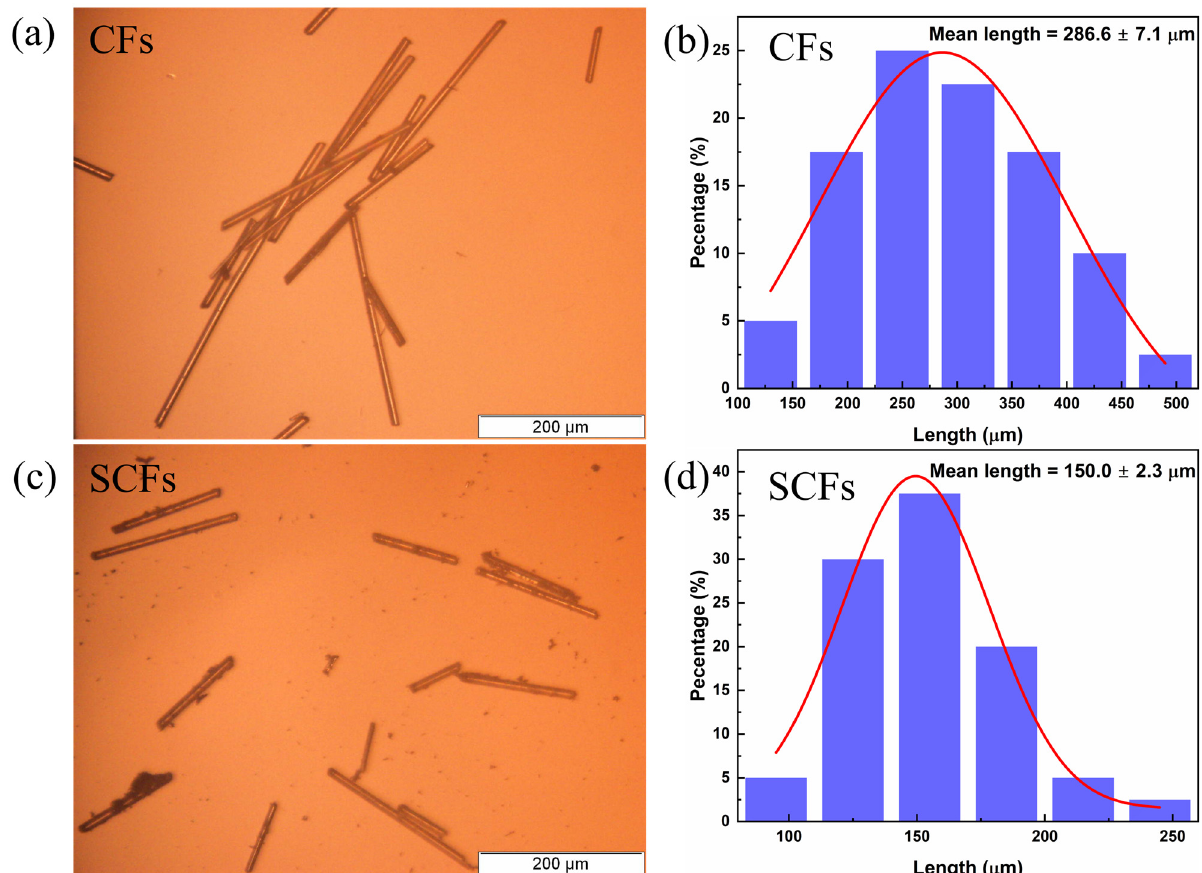
Figure 2. Microscopic images of the CFs and SCFs ( a , c ) and their length distributions with Gaussian fittings ( b , d ).